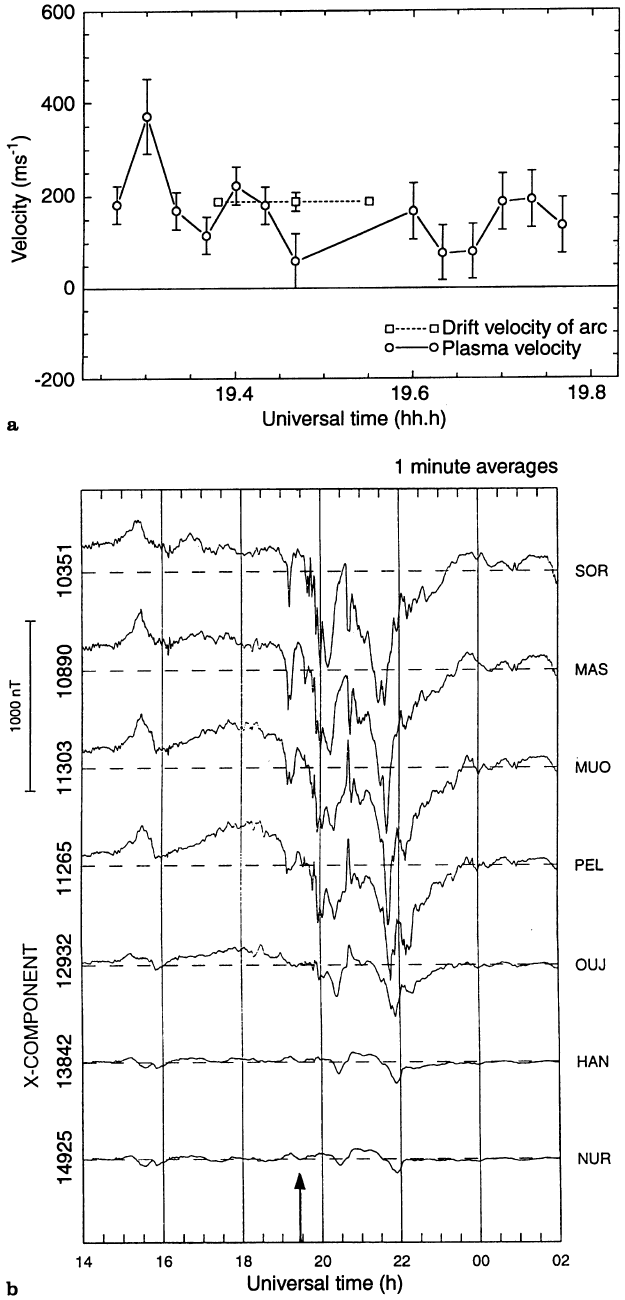
Fig. 5. a Comparison of arc drift velocity (indicated by broken line ) and plasma velocity in the same direction (indicated by continuous line ) for 1 March 1995. b X-component of magnetograms from the IMAGE network for 1–2 March 1995. The arrow indicates the time at which the arc